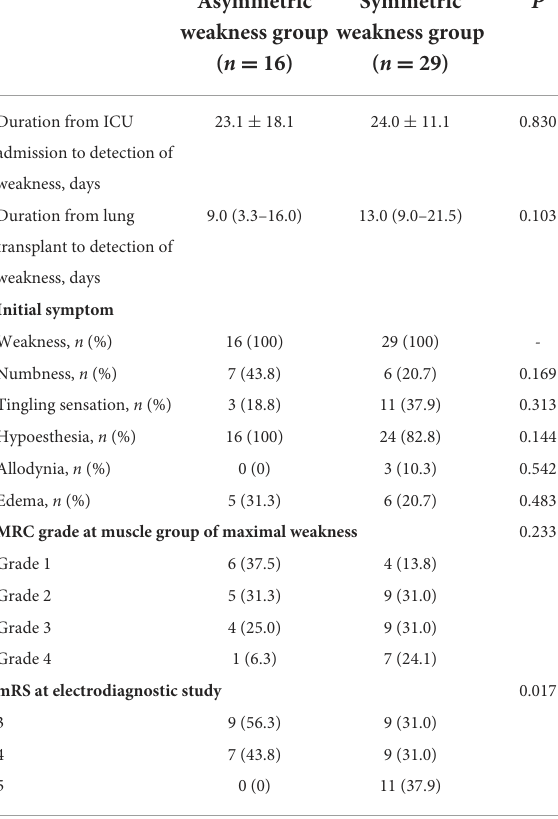
TABLE 2 Clinical features of patients who developed leg weakness after lung transplantation. Asymmetric